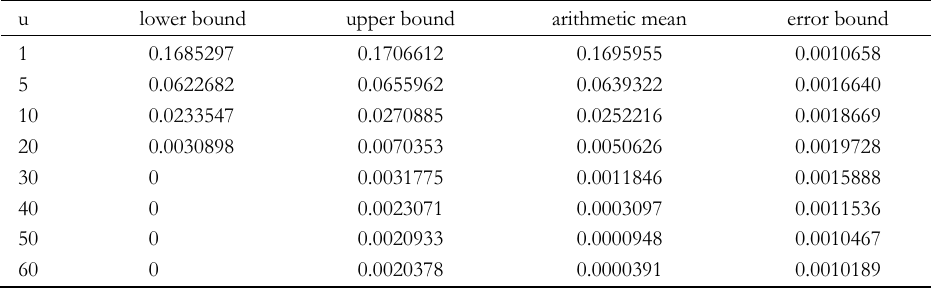
Inverse Gaussian, with mean 1 , variance 5 , (cid:84) = 2.5 and (cid:71) = ln(1+0.05), using (cid:39) (cid:32)